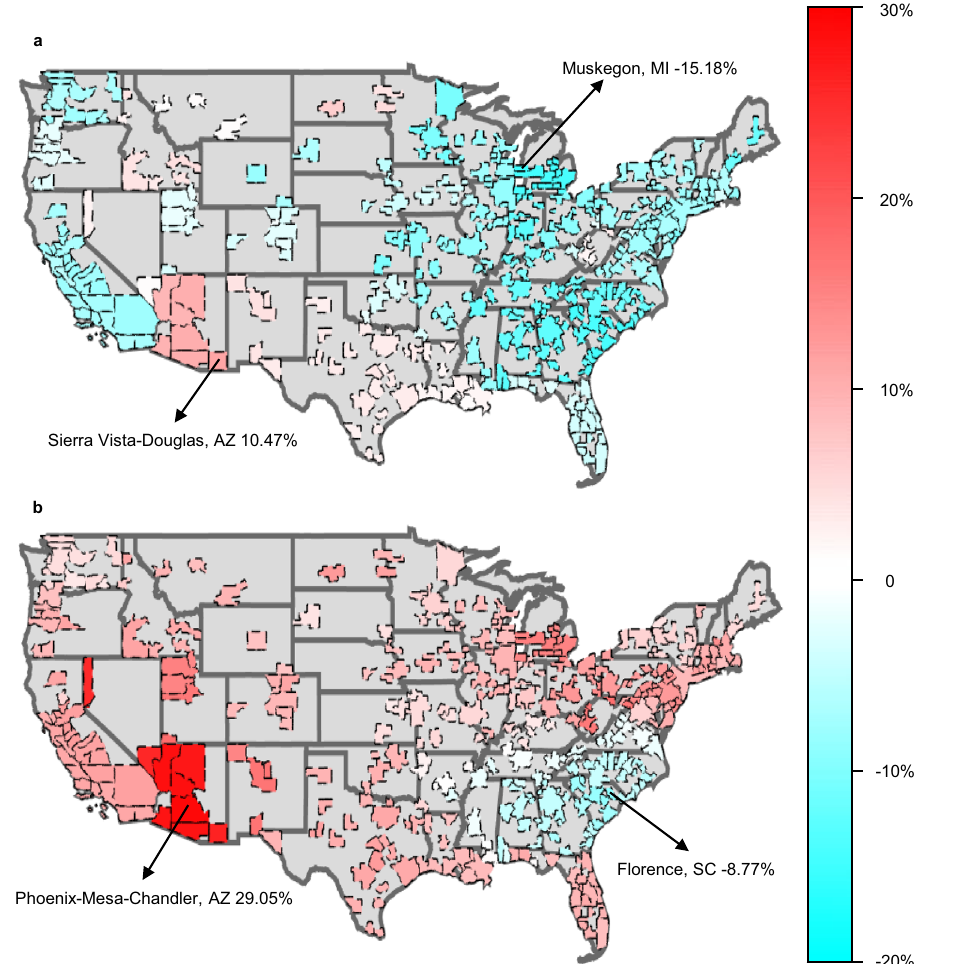
Fig. 3 | Spatial heterogeneity in EC change on metropolitan level after COVID-19. a Total EC change. b Residential EC change.